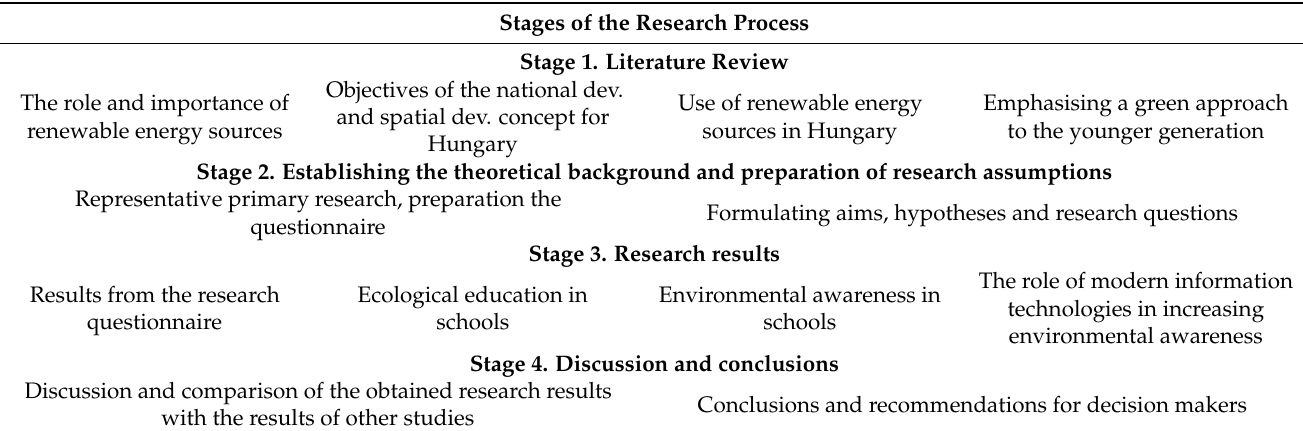
Table 2. The stages of the research